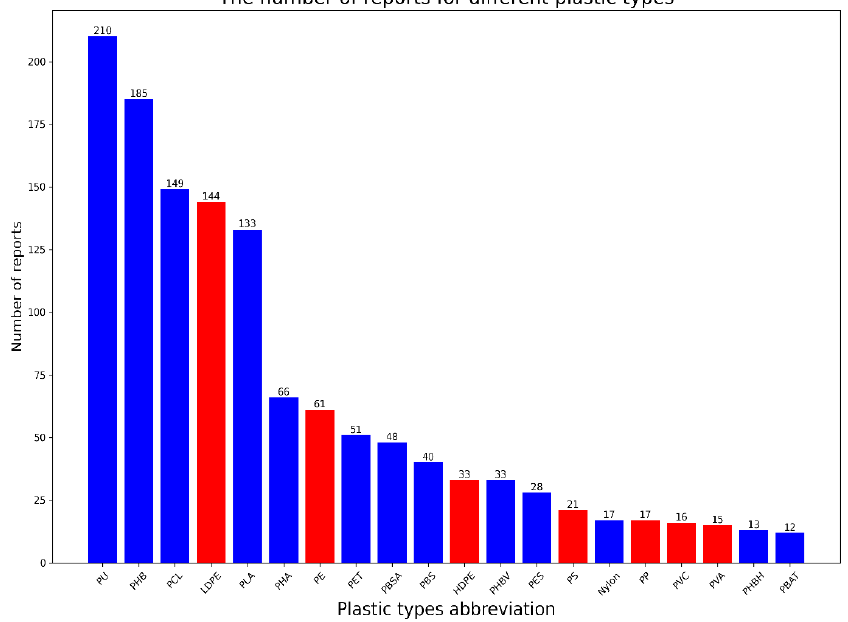
Figure 2. The frequency plot for different plastic types based on the number of publications reported for biodegradation of the corresponding plastics type. for biodegradation of the corresponding plastics